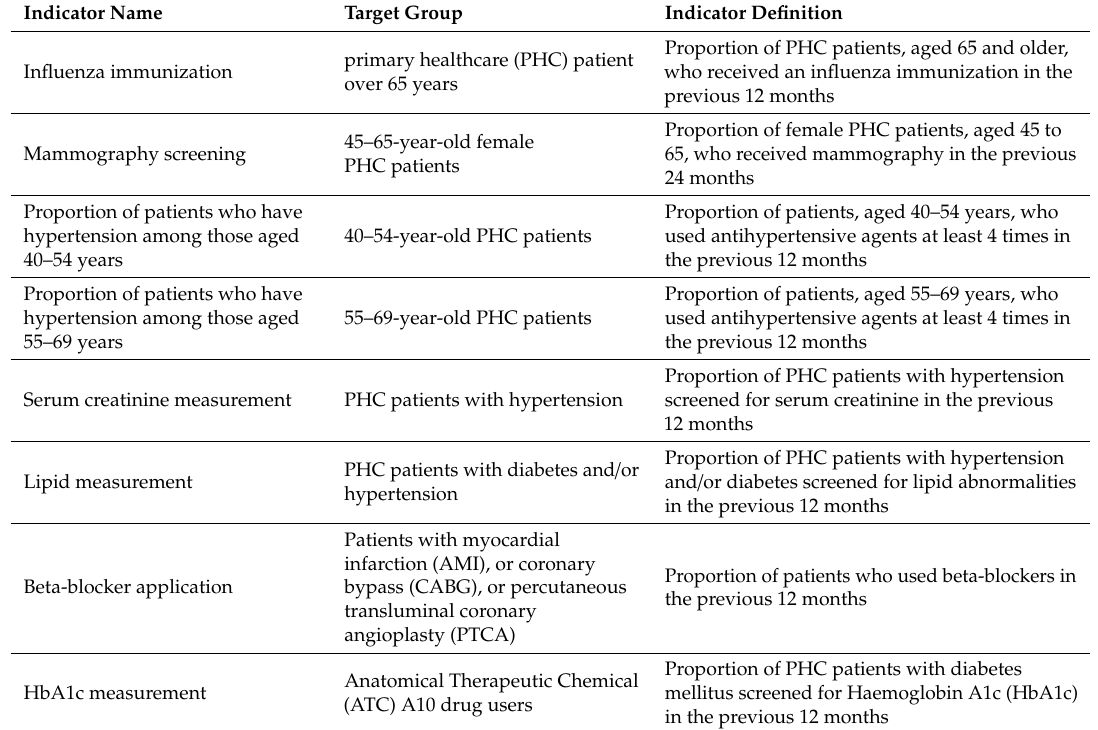
Table 1. The list of indicators (with target groups and definitions) used in primary healthcare responsible for the provision to adults in